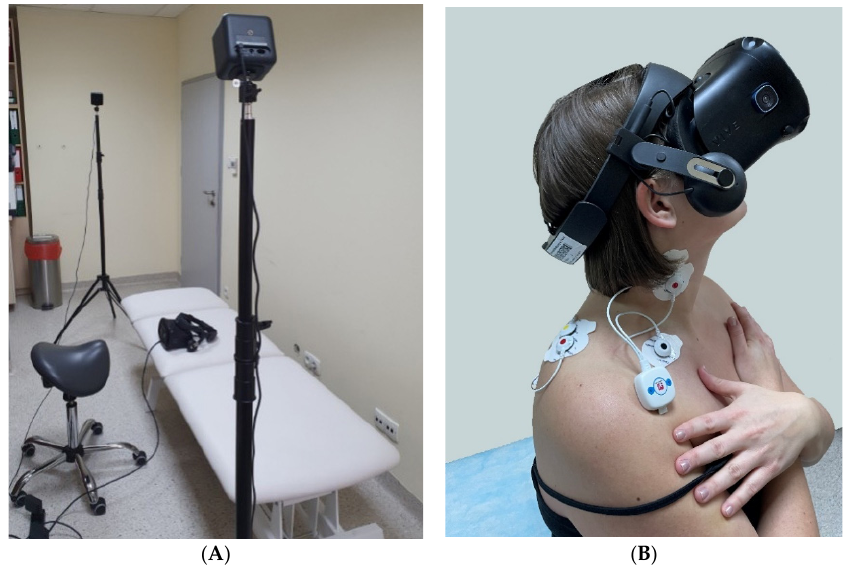
Figure 2. VRneck SOLUTION system: ( A )—system setting; ( B )—measurement of the muscle activity with VR goggles (HTC VIVE Cosmos Elite, HTC Corporation, New Taipei City, Taiwan) used to control functional movements.